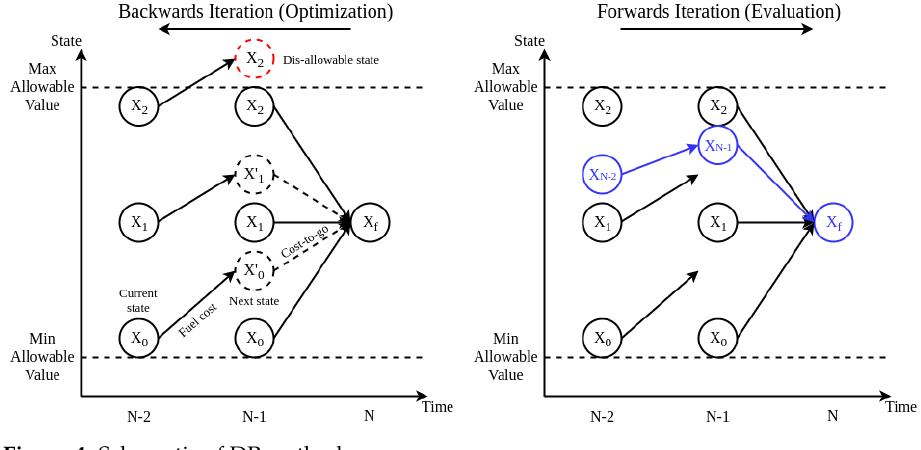
Figure 4. Schematic of DP